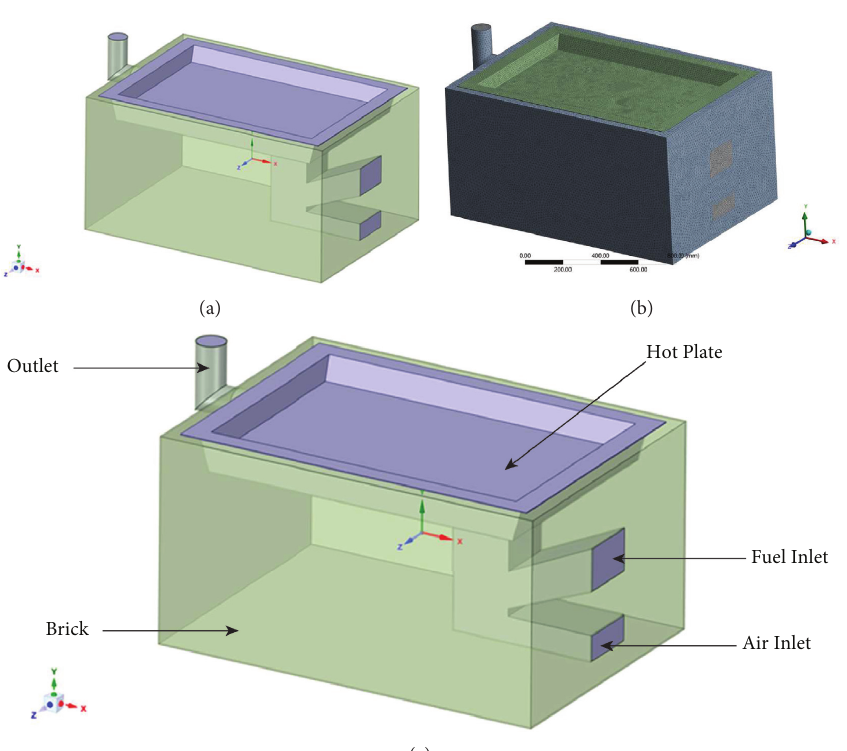
Figure 2: Hot plate roaster boundary